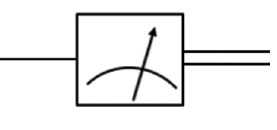
FIG. 8. Circuital representation of the measurement.